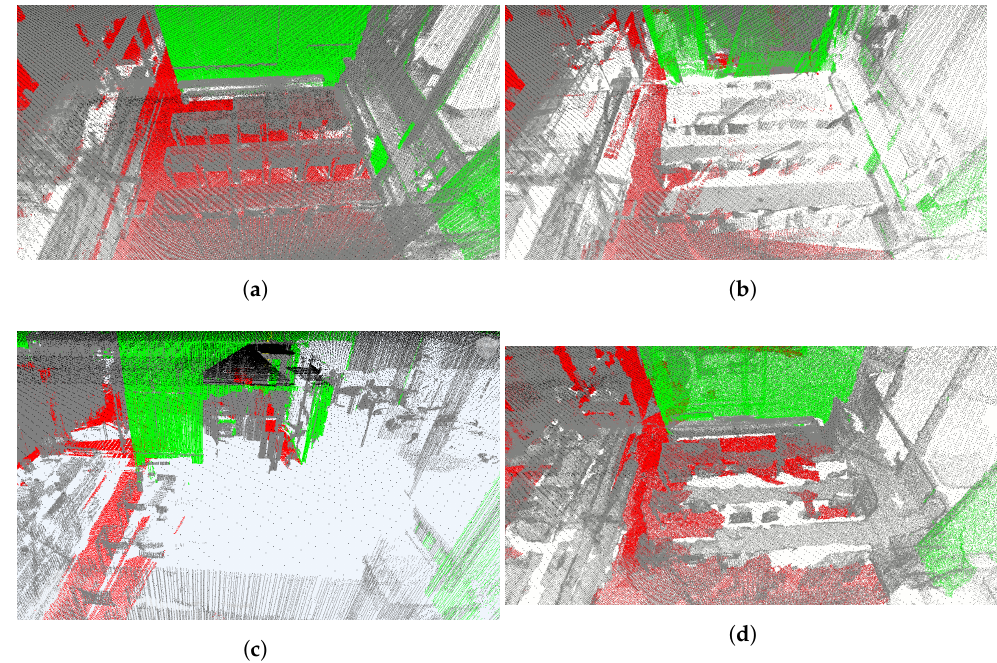
Figure 11. Accessibility shortcomings: Due to the limited space between the obstacles, the P30 and the M6 suffer from large occlusions. ( a ) VLX, ( b ) M6, ( c ) P30, and ( d ) Hololens 2.